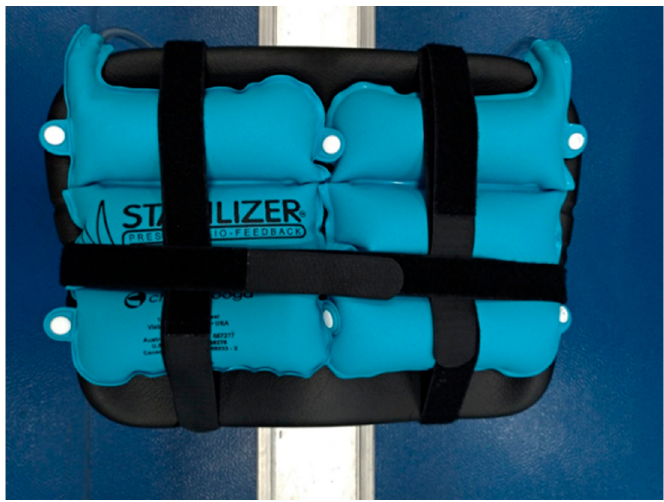
Figure 1. Pressure biofeedback unit.